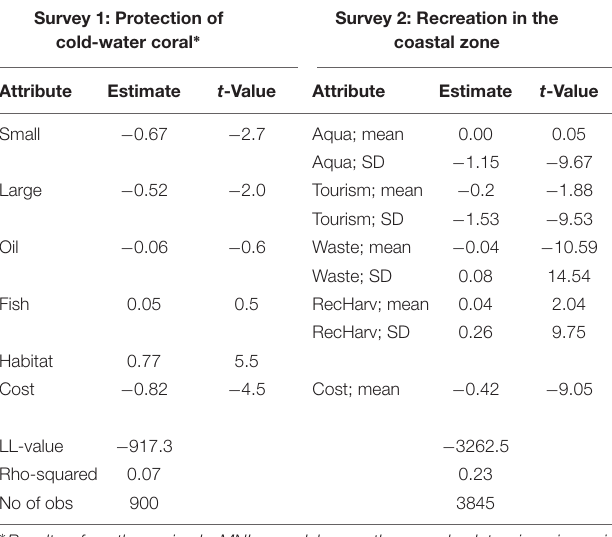
∗ Results for the mixed MNL model on the coral data is given in Appendix ( Table A1